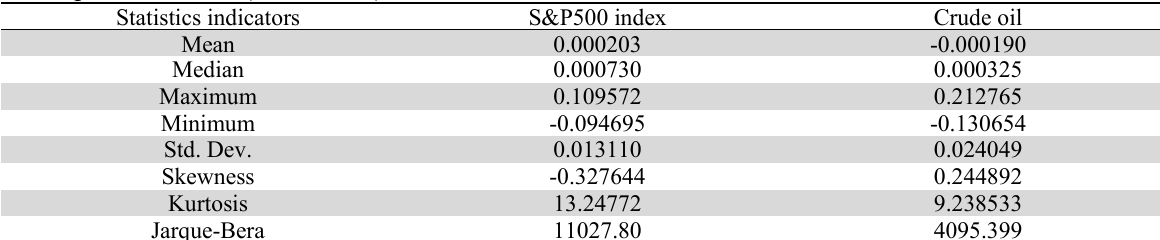
Descriptive statistics